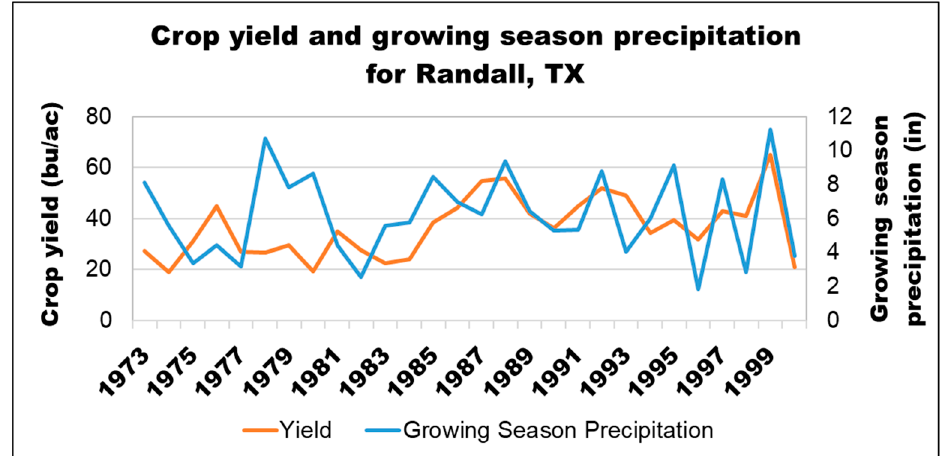
Figure 6. Sorghum yield reductions for Randall County in 1978 coming from excess growing season precipitation.